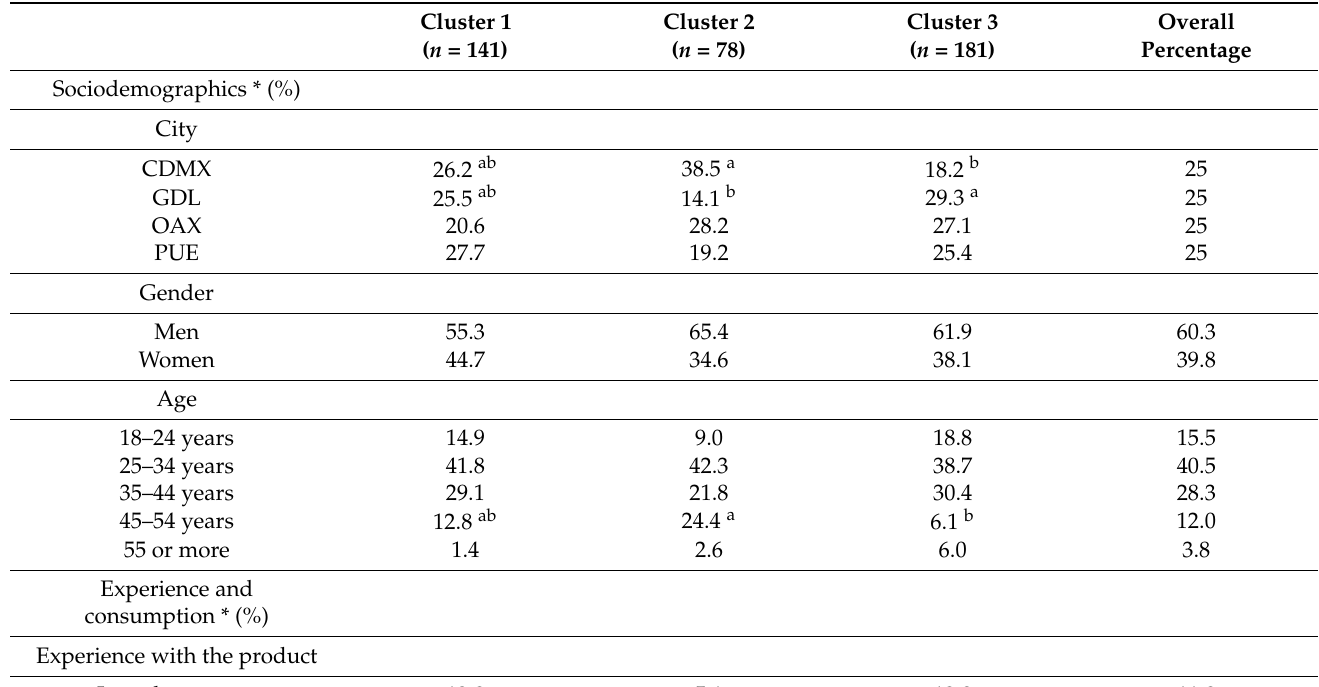
Table 4. Percentage of individuals in each sociodemographic level and consumption habits *, mean values of the different constructs ** and the traditionality dimensions *** within each segment of mezcal